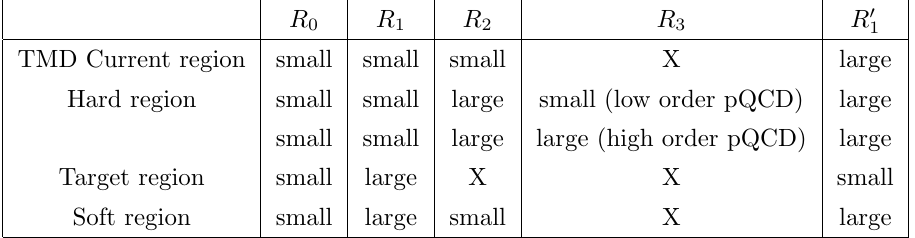
correspond to a region where we expect TMD factorization to apply, while for the large R 2 a collinear factorization will be